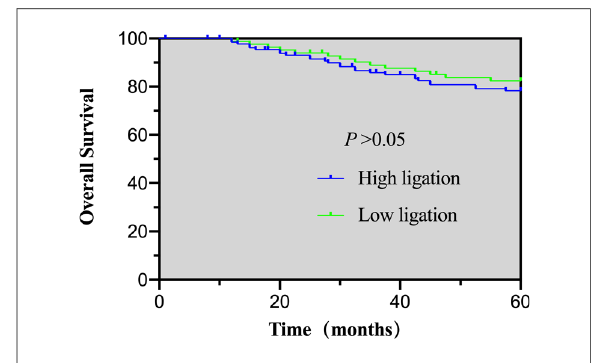
FIGURE 2 5-year overall survival of the high- and low-ligation